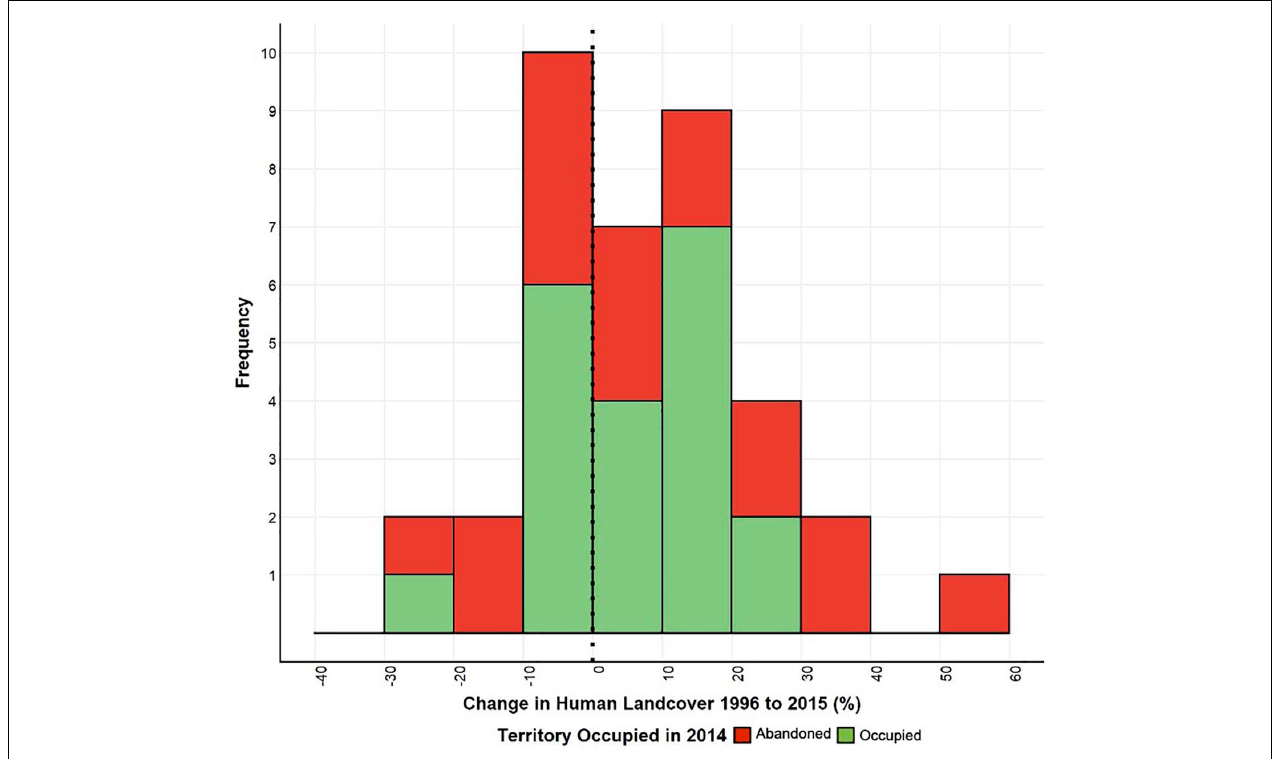
FIGURE 5 | Histogram of changes in total percent human development for each buzzard territory at 1 km.